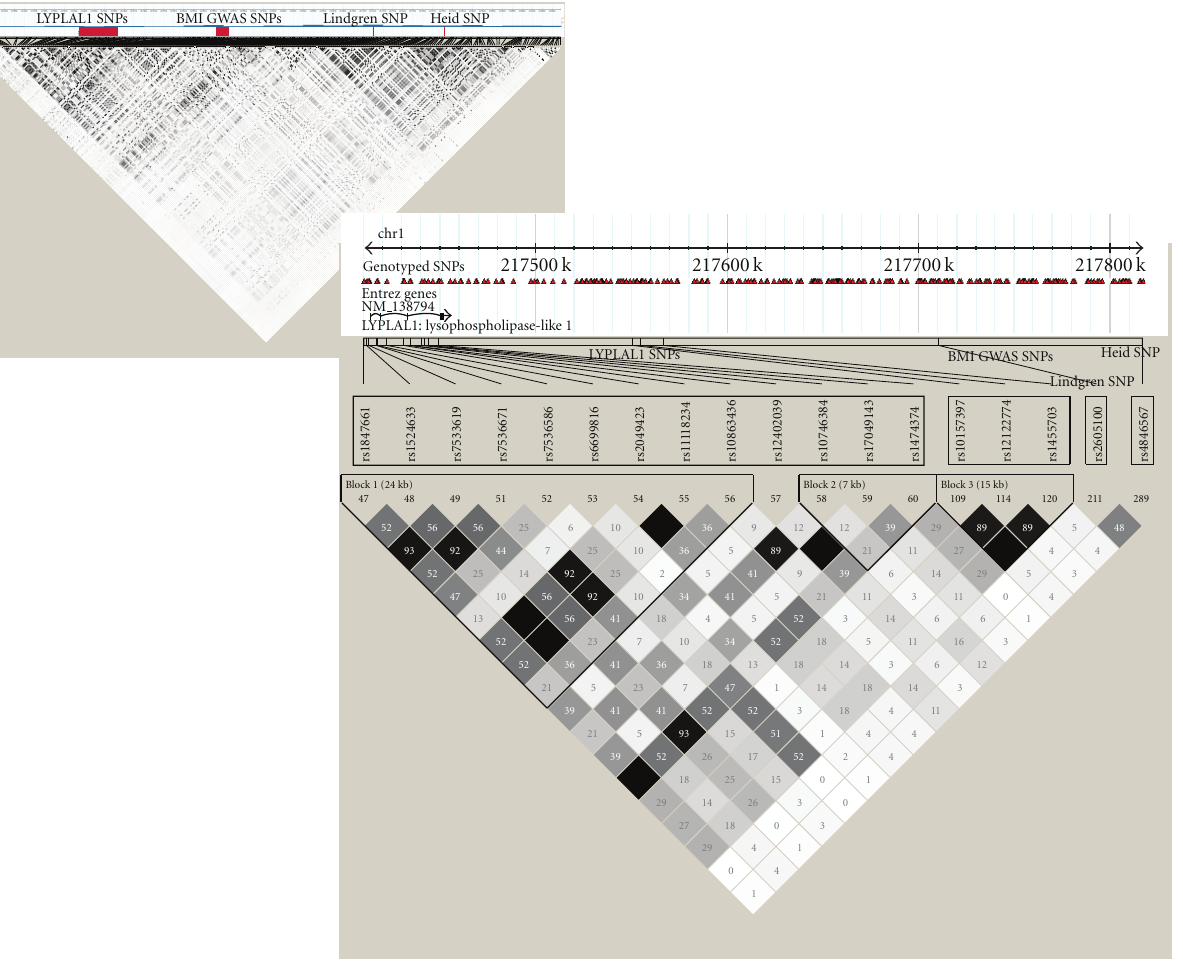
Figure 2: Linkage disequilibrium (shown as r 2 ) in the region encompassing LYPLAL1 , the consensus SNPs associated with body mass index (BMI) in our gene by sex interaction GWAS, and the sex-specific SNPs associated with waist to hip ratio (WHR) in recent GWAS meta- analyses.